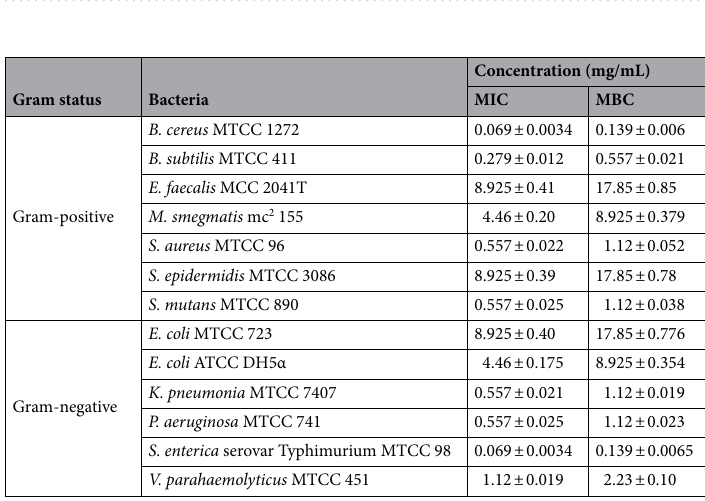
Table 3. Table presenting summarized details of RSM models.